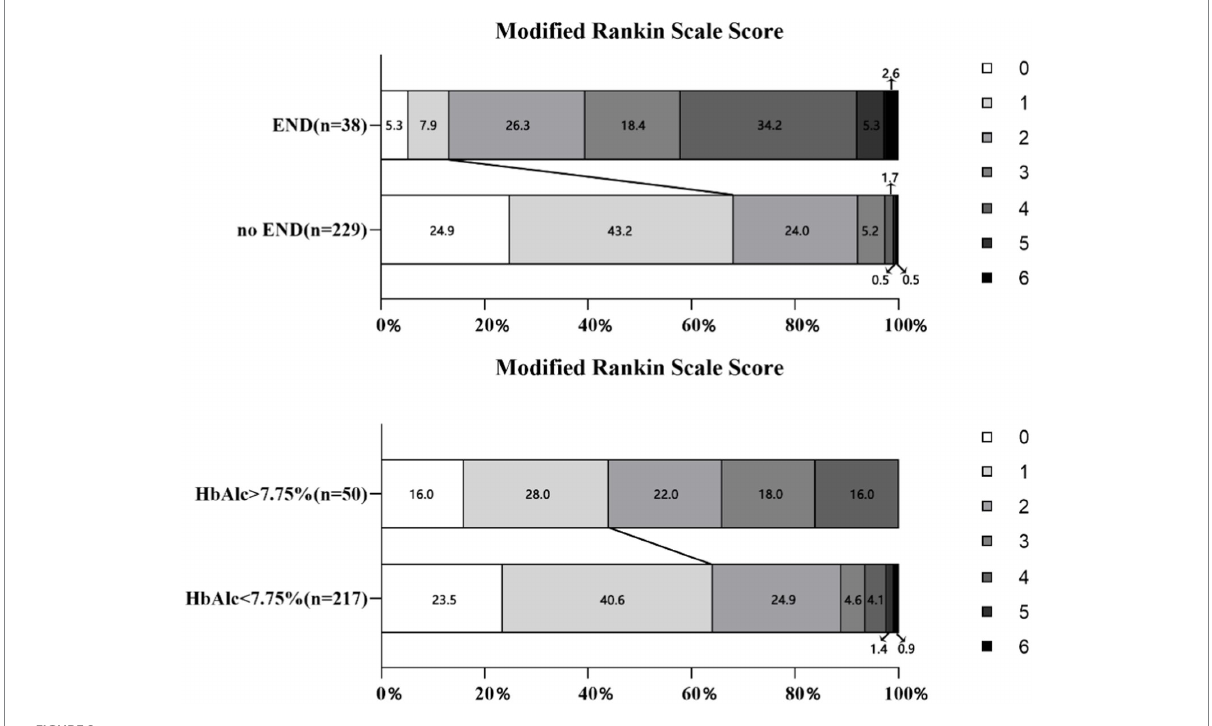
FIGURE 2 Distribution of scores on the modified Rankin Scale at 90